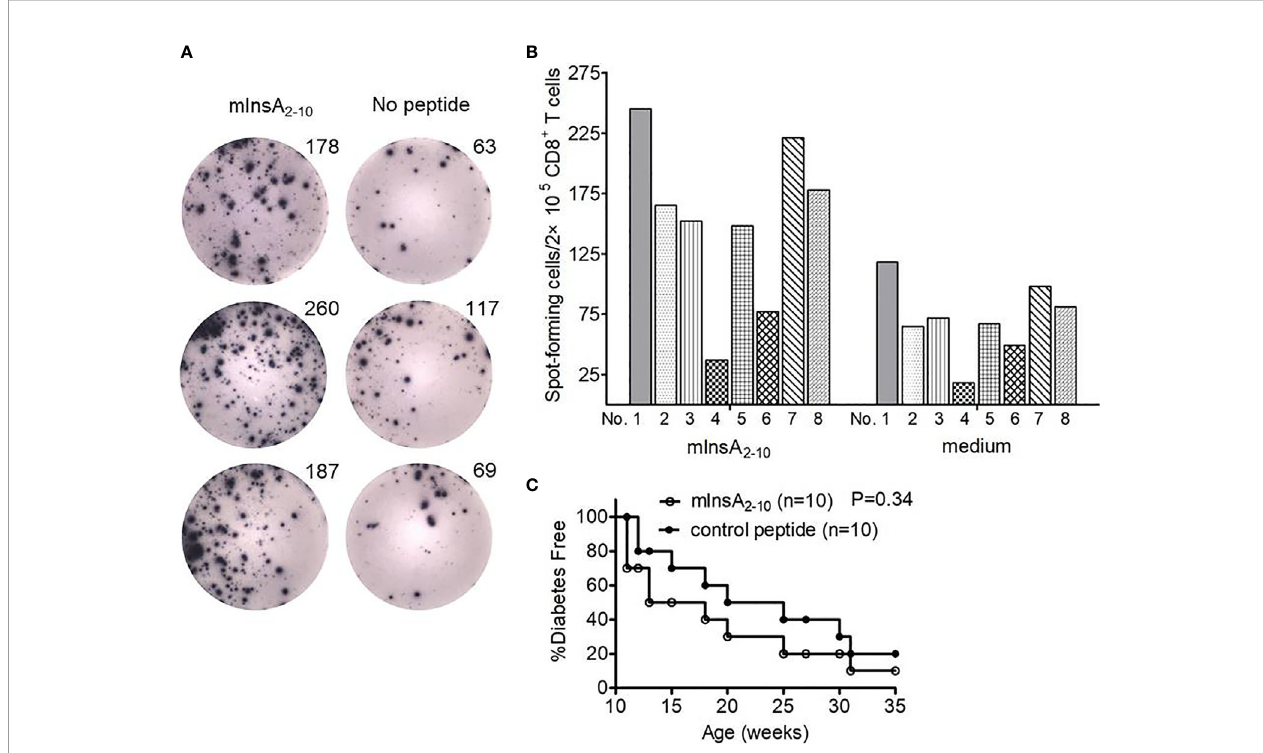
FIGURE 1 | The mInsA 2-10 epitope treatment could not prevent the development of T1D in NOD. b 2 m null .HHD mice. (A) Representative IFN- g ELISPOT assay demonstrated splenic CD8 + T cell responses to T2 cell-loaded mInsA 2-10 (10 m g/ml), or no peptide in 12-week-old non-diabetic female NOD. b 2m null .HHD mice. (B) The average number of peptide-speci fi c IFN- g -positive spots per 2×10 5 splenic CD8 + T cells in triplicate cultures was calculated for each indicated peptides (10 m g/ ml) or no peptide from eight separate experiments. SDs are not shown to avoid excessive visual clutter. (C) Percentage of female NOD. b 2m null .HHD mice developing diabetes after 100 m g mInsA 2-10 i.p. weekly injections from 4 to 9 weeks of age (white circles, n = 10) vs. mice that were treated with OVA 257-264 (black circles, n =